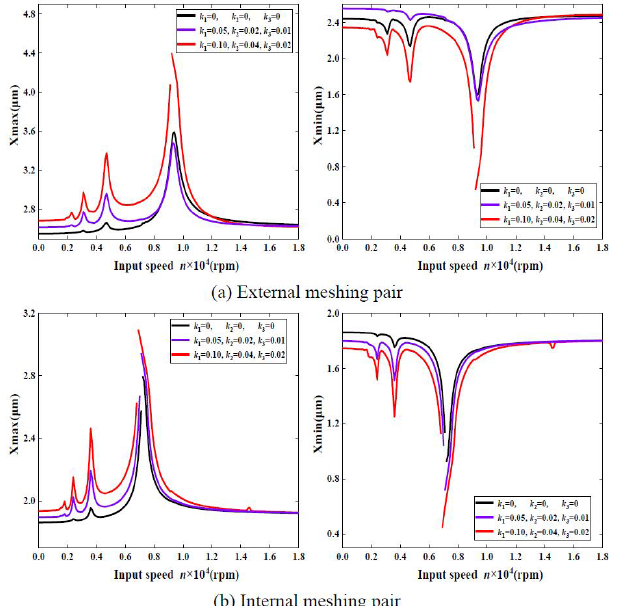
Figure 8. Effect of the external exciting force on the vibration re- sponse